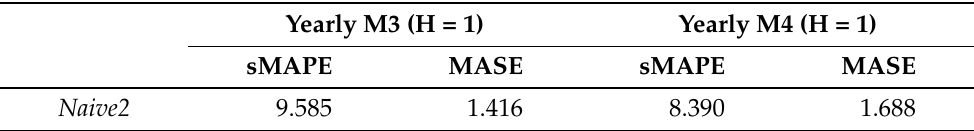
Table 3. Average MASE and sMAPE of 1-step Naive forecasts, forecasting the last observation of the training